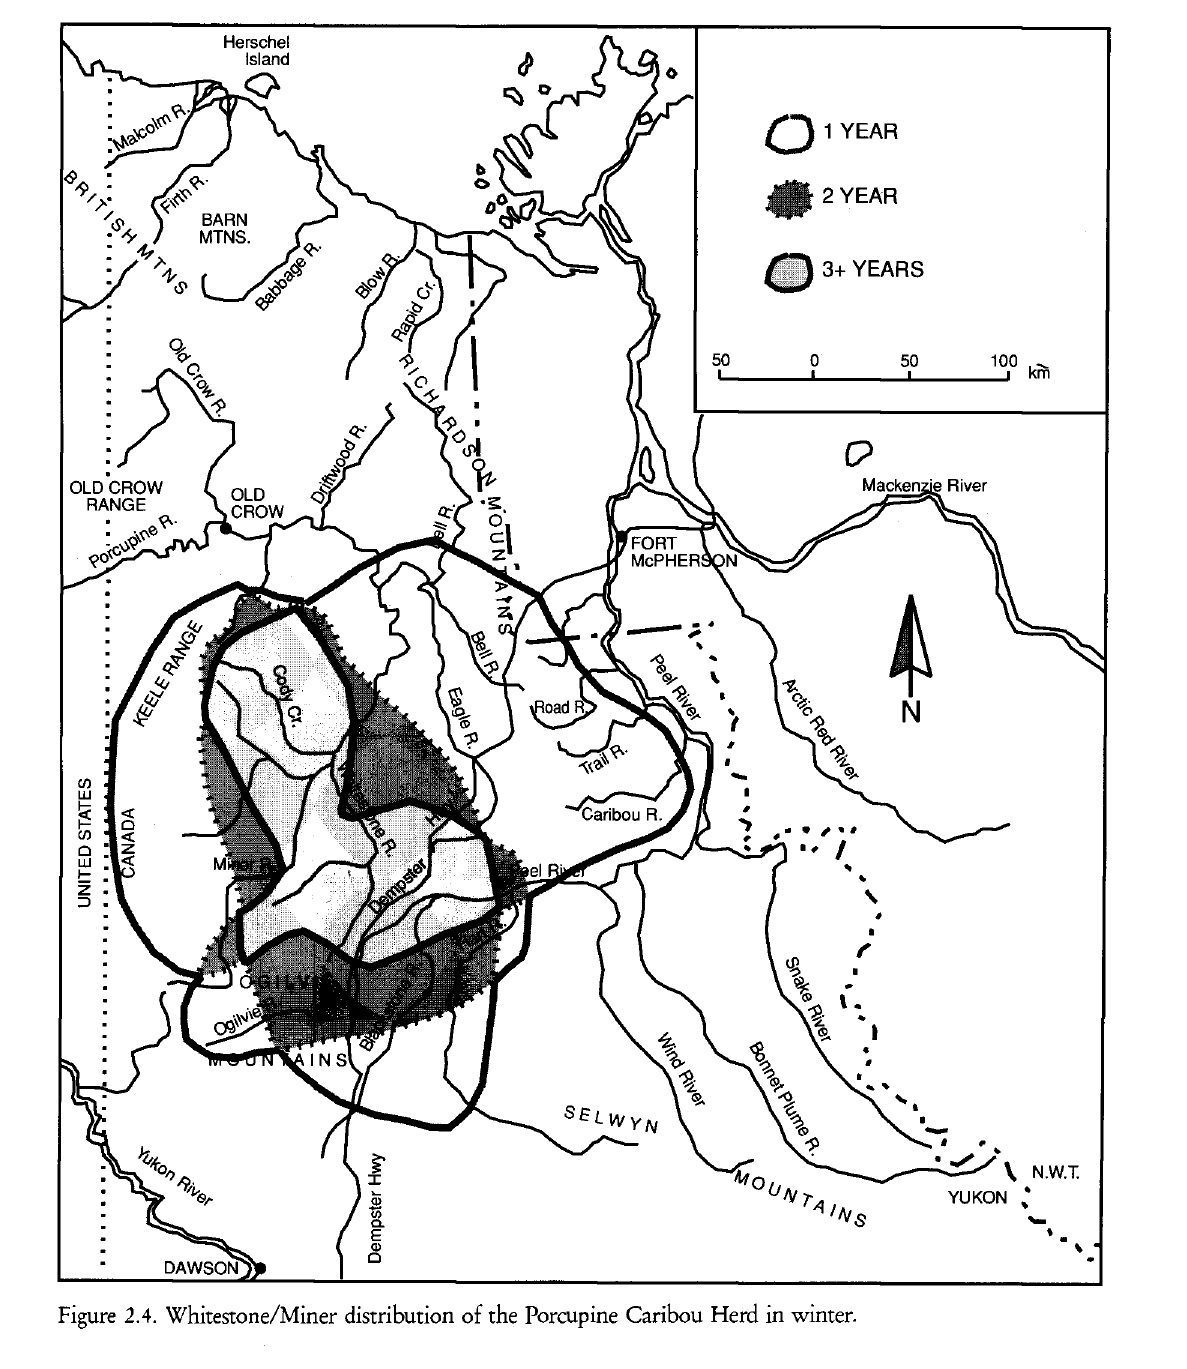
Figure 2 .4. Whitestone/Miner distribution of the Porcupine Caribou Herd in